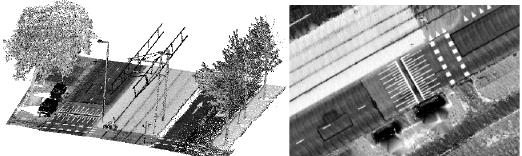
Figure 4. Point cloud patch on the left is converted to an ortho image on the right.